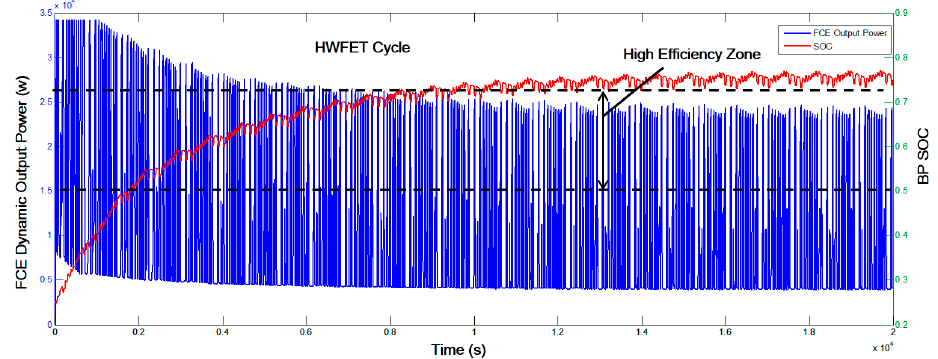
Figure 12. Vehicle control algorithm evaluation testing under the HWFET cycle with battery pack SOC and FCE dynamic output power parameters.